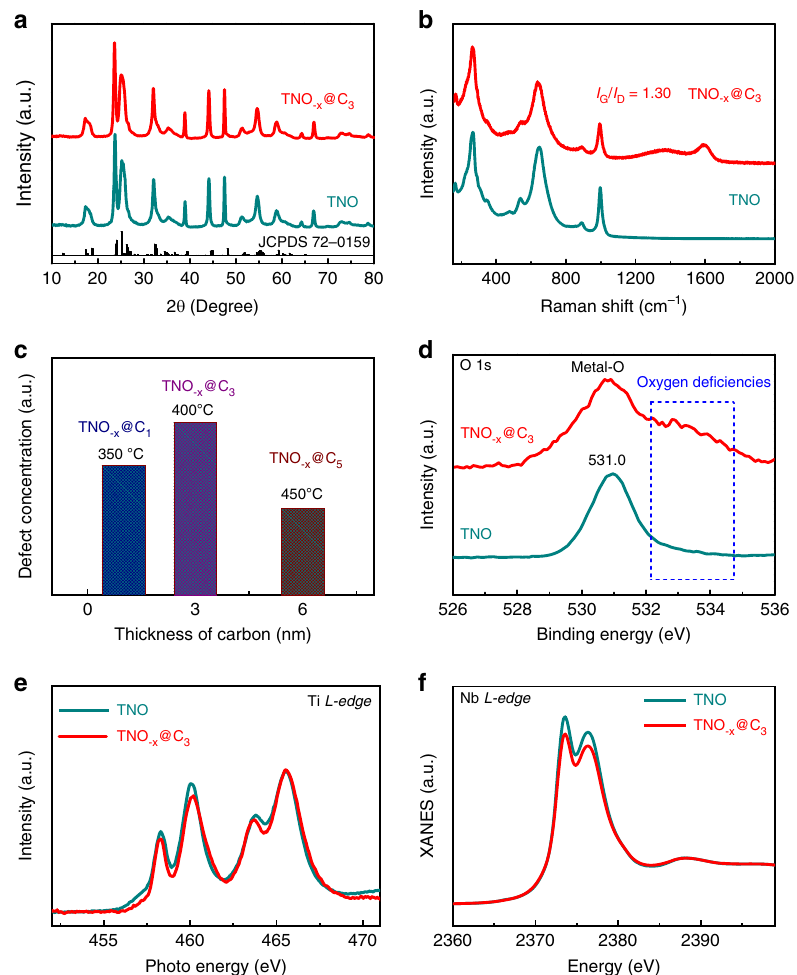
Fig. 2 Phase and composition characterization of TNO and TNO − x @C 3 . a XRD patterns. b Raman spectra. c The relationship of defect concentration and thickness of carbon. d XPS spectra of O 1 s. e XANES spectra of Ti L -edge. f XANES spectra of Nb L